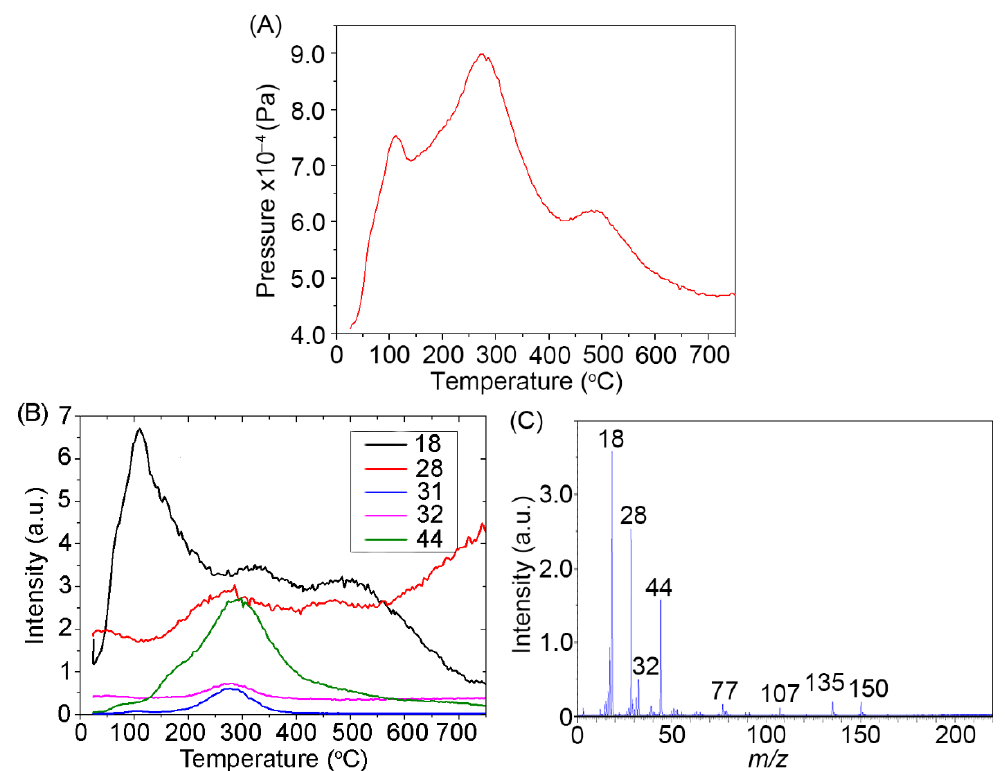
Figure 10. ( A ) Vapor pressure of pyrolysis products measured as a function of temperature. ( B ) TPD-curve for the ions with m / z 44 (CO 2 ), 32 (MeOH), 31 (MeOH), 28 (CO), and 18 (H 2 O) for the FA/regenerated-Al 2 O 3 sample. ( C ) Mass spectra at 220 ◦